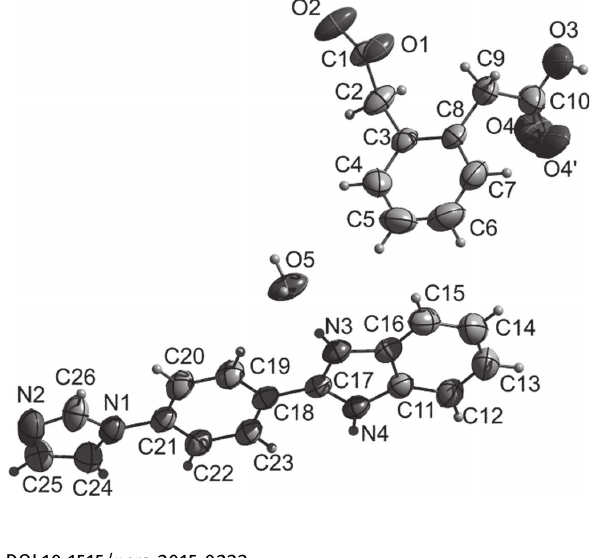
Table 1: Data collection and handling.